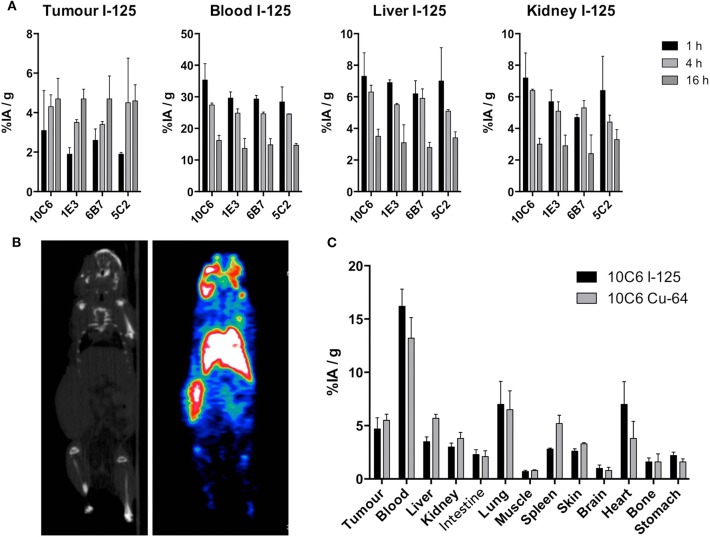
Biodistribution of anti-CD22 antibodies and PET imaging of CLBL-1 xenografts in nude mice. (A) Biodistribution to tumors, blood, liver, and kidney 1, 4, and 16 h after injection of 6.10−6 g of 10C6, 1E3, 5C2, and 6B7 radiolabeled with 125I. Here are shown the mean results ± standard deviation obtained on three mice. (B) PET-CT imaging 16 h after injection of 64Cu-10C6. The CLBL-1 cell line was engrafted in the left flank of nude mice. Left panel: CT scan of the imaged mouse. Right panel: PET imaging showing the radiolabeled tumor in the left flank of the nude mouse. (C) Comparison between the biodistribution of 10C6 radiolabeled with 125I and 64Cu. Immediately after imaging at 16 h post-injection of the 64Cu-radiolabeled antibody, the mouse was sacrificed and the biodistribution in the different organs of interest was evaluated and compared to the biodistribution of 125I-10C6 at the same time point.